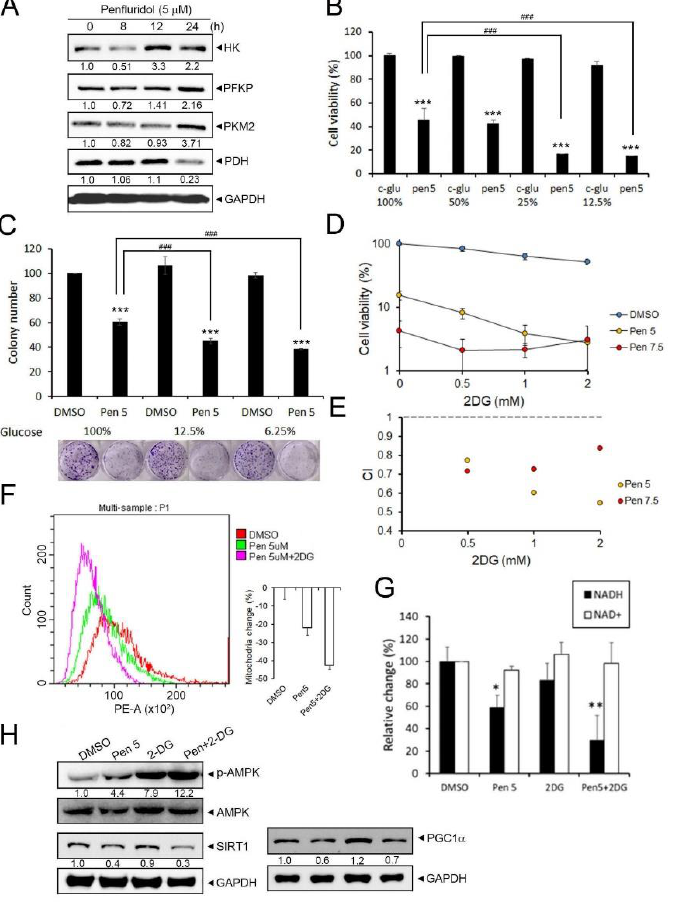
Figure 3. 2 − Deoxy − D − glucose (2DG) combined with penfluridol significantly reduces cell growth ability, which indicates a synergetic interaction between 2DG and penfluridol for human non − small cell lung cancer (NSCLC) cells. ( A ) A549 cells were treated with vehicle or penfluridol for the indicated time points and then subjected to a Western blot analysis to detect glycolysis − related markers. GAPDH was used as an equal loading control. Western blots shown are representative results from 3 independent experiments. ( B , C ) A549 cells were treated with vehicle or 5 µM penfluridol and cultured in complete medium containing indicated concentration of glucose (100%~6.25%), and the proliferative ( B ) and colony − forming ( C ) abilities were determined. Values are presented as the mean ± SD from three independent experiments. *** p < 0.001 compared to the vehicle group. ### p < 0.001 compared to penfluridol − treated cells cultured in medium with 100% glucose. ( D , E ) A549 cells were treated with 5 or 7.5 µ M of penfluridol with various concentrations of 2DG for 24 h. Then, the cell viability was determined by an MTS assay ( D ), and values of the combination index (CI) were calculated using the Compusyn software package ( E ), which were interpreted as follows: >1 antagonism, <1 synergism, and =1 additive. ( F ) For the flow cytometric analysis, cells were stained with MitoTracker Red H2XRos. A representative histogram (left panel) and bar graph ( n = 3) (right panel) of the flow cytometric analysis among vehicle − , penfluridol (5 µ M) − , and 2DG (1 mM)+penfluridol − treated A549 cells are depicted. ( G ) Changes in NAD+ and NADH in A549 cells treated with vehicle, penfluridol (5 µ M), 2DG (1 mM), or penfluridol+2DG for 24 h. Data are shown as the mean ± SD from three independent experiments. * p < 0.05, ** p < 0.01 compared to the vehicle group. ( H ) A549 cells were treated with vehicle, penfluridol, 2DG, or penfluridol+2DG for 24 h and then subjected to a Western blot analysis to detect expression levels of phosphorylated (p) − AMP − activated kinase (AMPK), sirtuin 1 (SIRT1), and peroxisome − proliferator − activated receptor co − activator − 1 α (PGC − 1 α ). GAPDH or AMPK was used as an equal loading control. Western blots shown are representative results from 3 independent